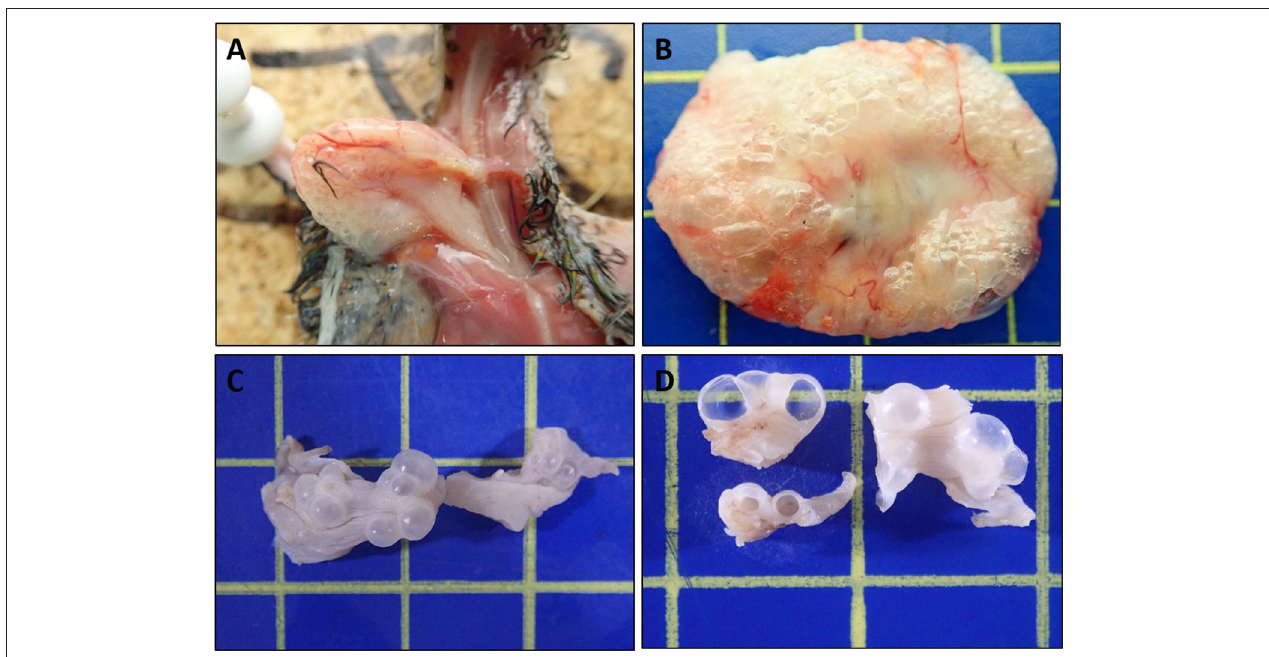
FIGURE 1 | Macroscopic features of Nectarivorous Bird Emphysematous Ingluvitis (NBEI) in Loriinae Birds (A–D) . (A) Case 8, emphysematous crop [ in-situ ] and (B) Case 9, emphysematous crop [fresh excised tissue]; both exhibiting diffuse submucosal to transmural gas-filled cavities (emphysema), distension and mural thickening. (C,D) Case 10, emphysematous crop [10% formalin fixed excised tissue]. (C) Intact multifocal to coalescing exophytic gas-filled cavities and (D) cut surfaces of cavities. (Blue cutting board used as background: each box 1cm 2